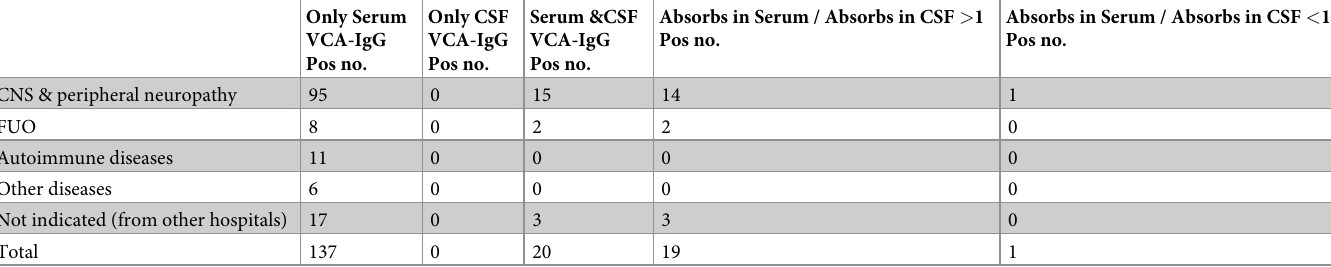
Table 5. EBV VCA-IgG antibodies in the 157 paired samples from patients with various symptoms or